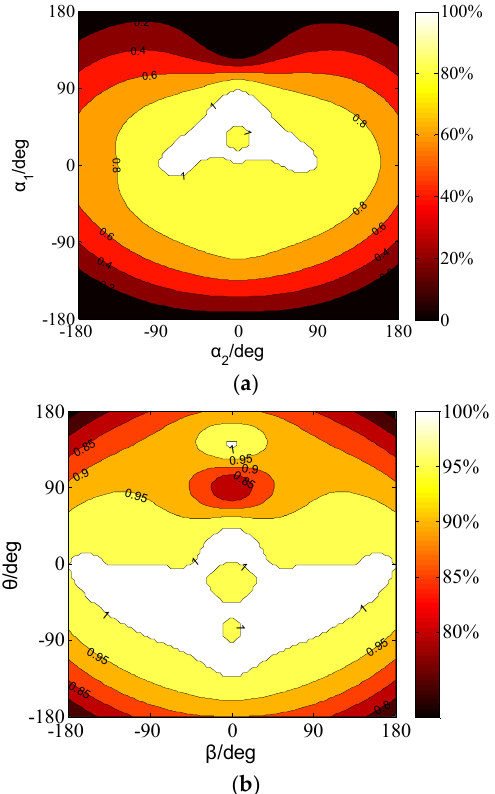
Figure 24. Effect of changing tag attitude angles on tracking performance. ( a ) Contour map of success tracking rate against tag deflection angles α 1 and α 2 . ( b ) Contour map of success tracking rate against DOA (θ) and tag axial rotation angle, β.